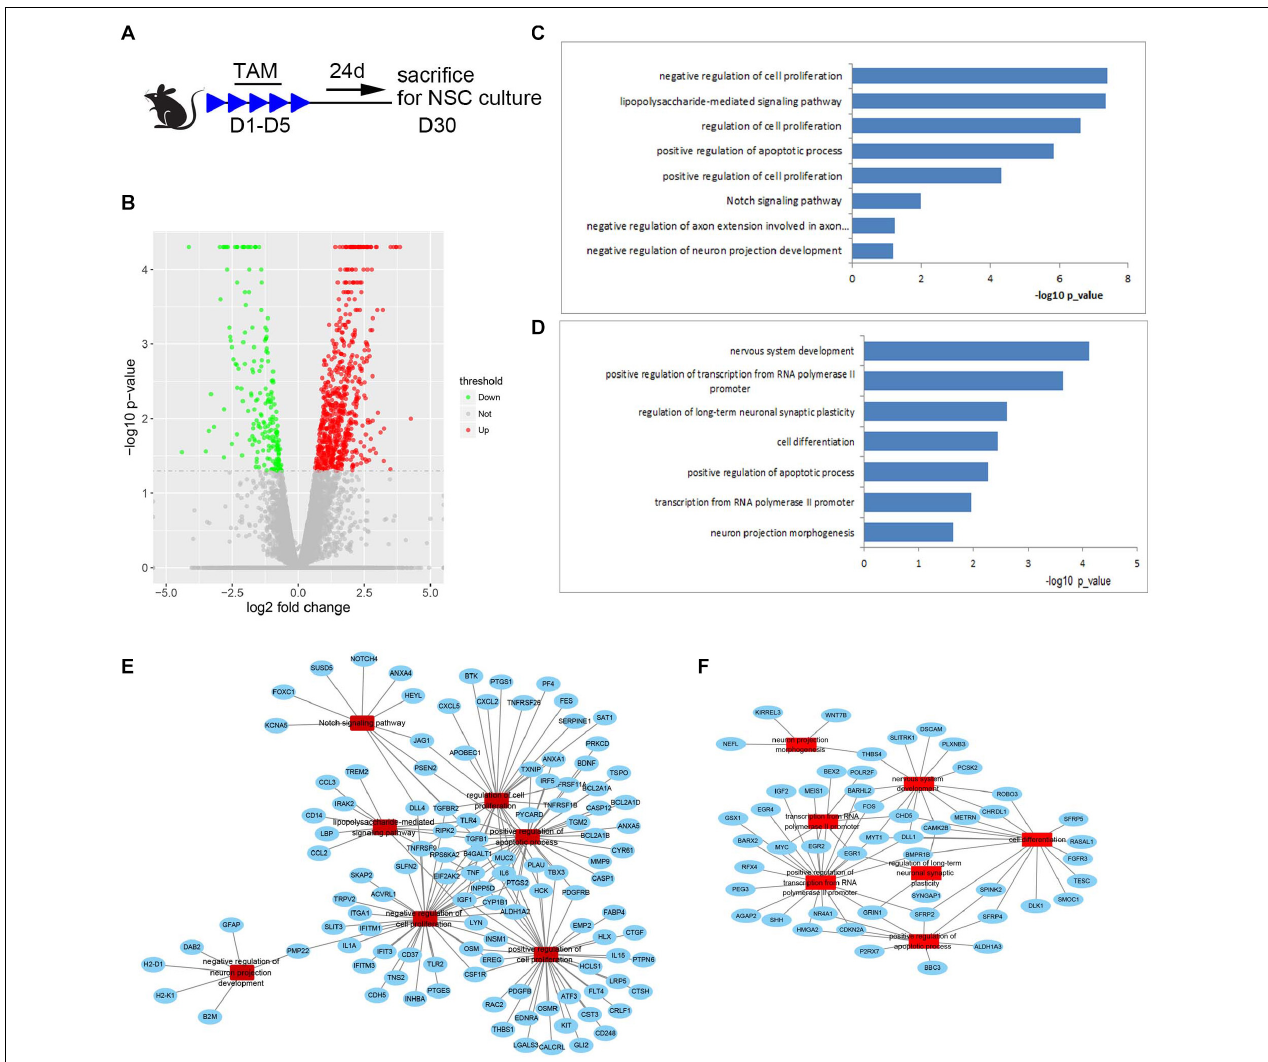
FIGURE 8 | Transcript profiling of Med23-deficient hippocampal NSCs. (A) Schematic representation of TAM treatment and sample collection schedule. (B) Volcano plots depict gene expression changes between Med23 CKO and control NSCs. Significantly differential transcripts are highlighted in color and totaled in each direction (FDR < 0.05). The cultured neurospheres prepared from individual mouse brain were collected as one sample for RNAseq analysis, and n = 3 in each group. (C,D) Gene ontology (GO) analysis of the significantly upregulated (C) and downregulated (D) genes between Med23 CKO and control NSCs. (E,F) Protein-protein interaction networks among upregulated (E) and downregulated (F) genes in Med23 CKO